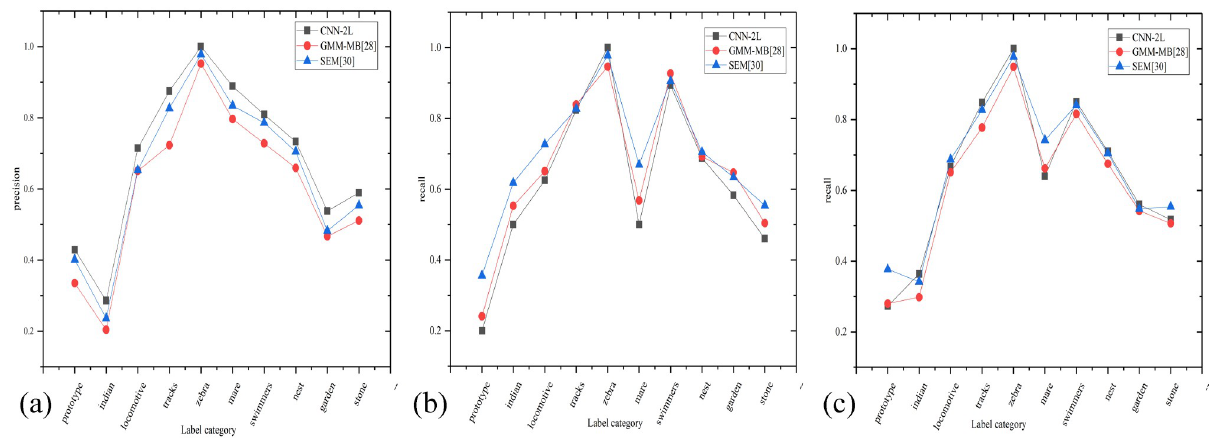
Fig 7. Experimental comparisons of single category indexes under different algorithms.